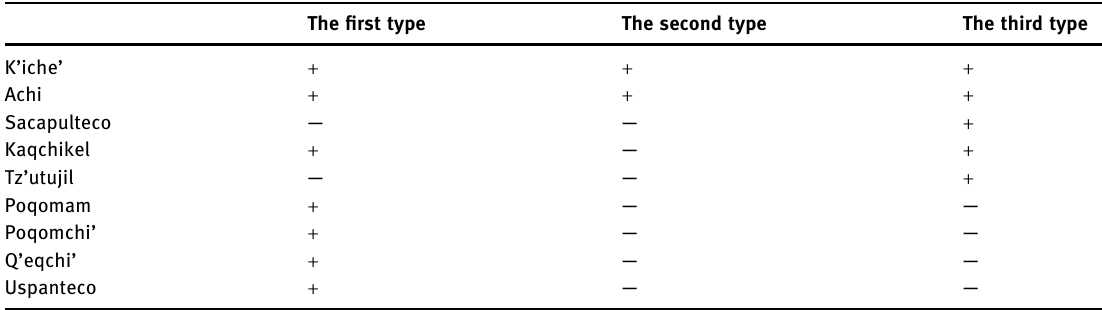
Table 5: Morphosyntactic features of aspectual predicates in progressive in K ’ iche ’ an